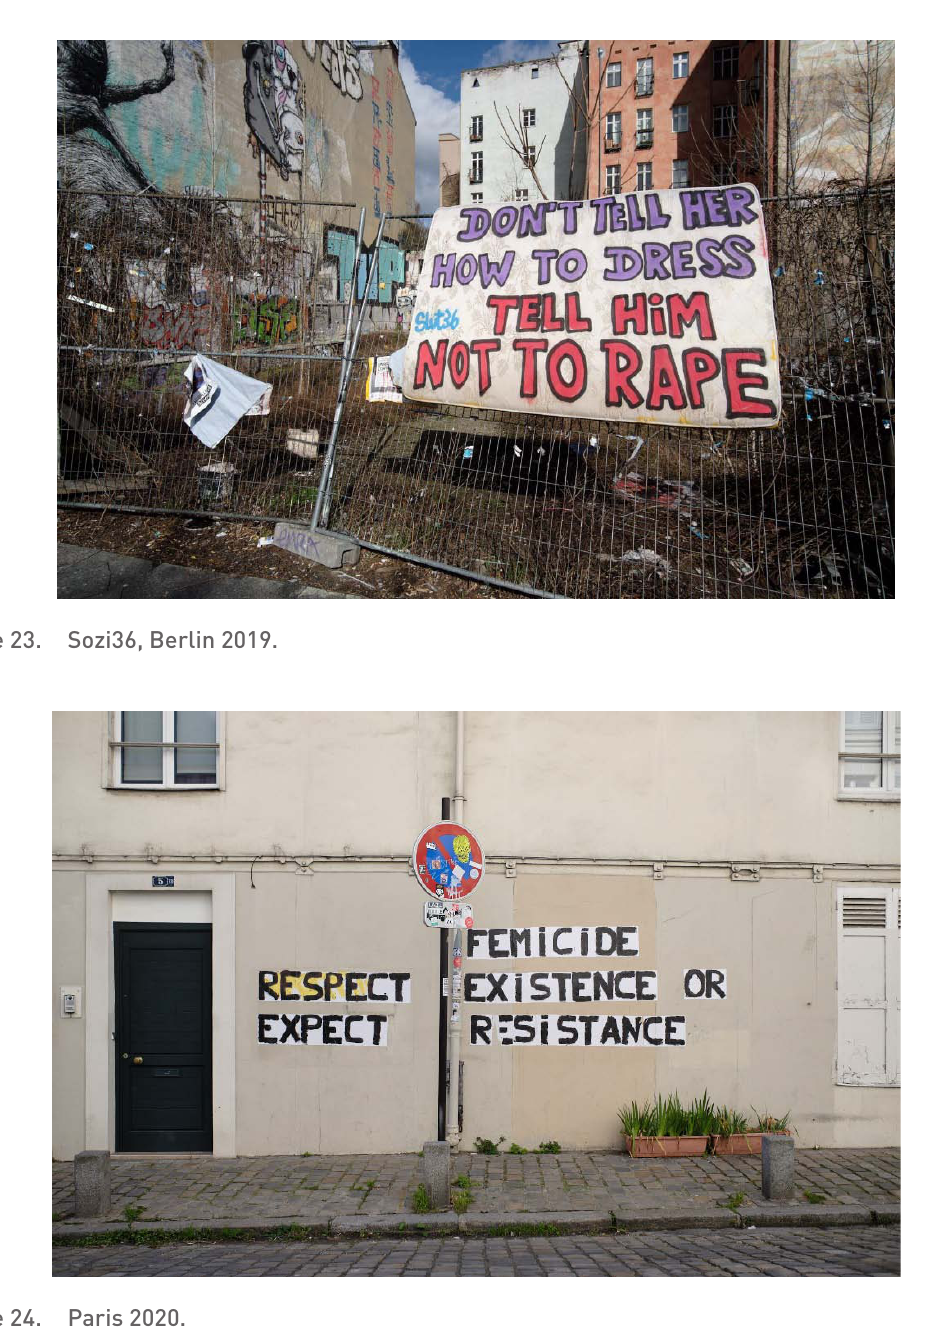
Figure 24. Paris